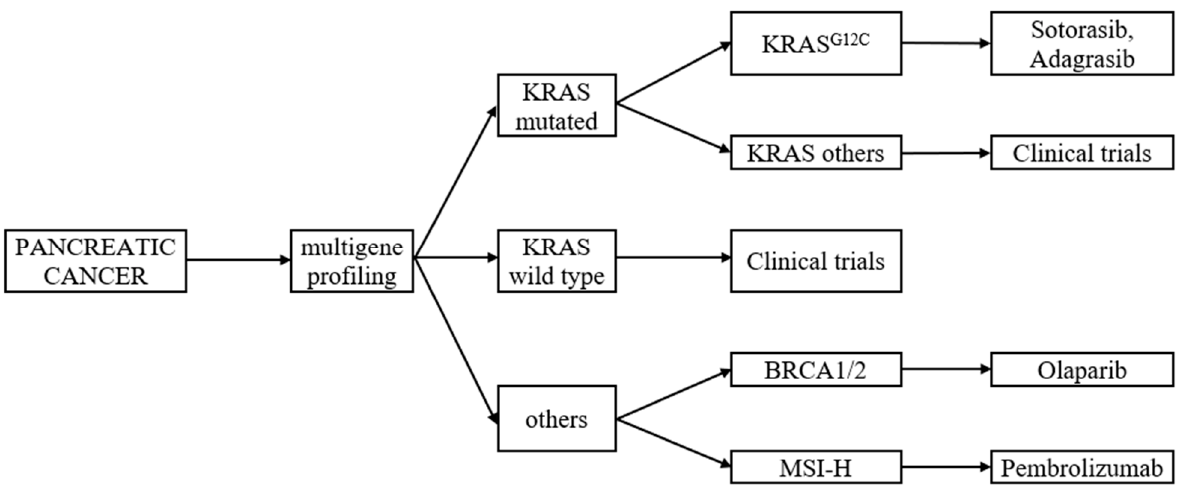
Figure 1. Multigene profiling of metastatic pancreatic cancer, with regard to KRAS mutation. Based on the literature review of [20–25].